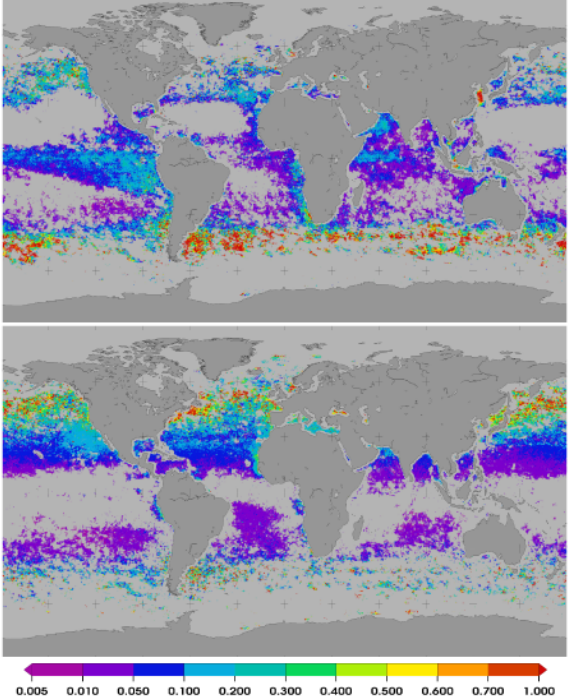
Fig. 6. Global distribution of chl a [mgm − 3 ] for coccolithophores (upper panel) and dinoflagellates (lower panel), retrieved via the PhytoDOAS method in the triple-target mode from SCIAMACHY data; monthly averages over October